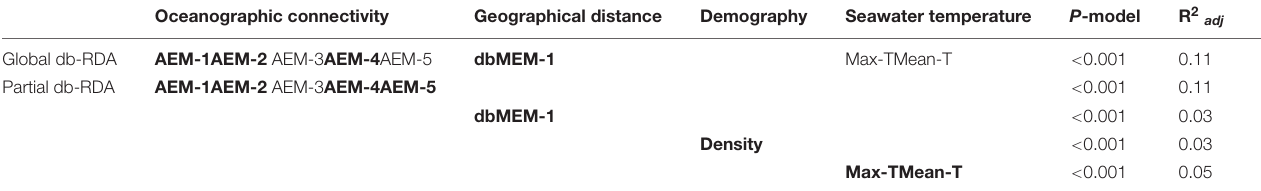
TABLE 3 | Global and partial distances based RDA (db-RDA).